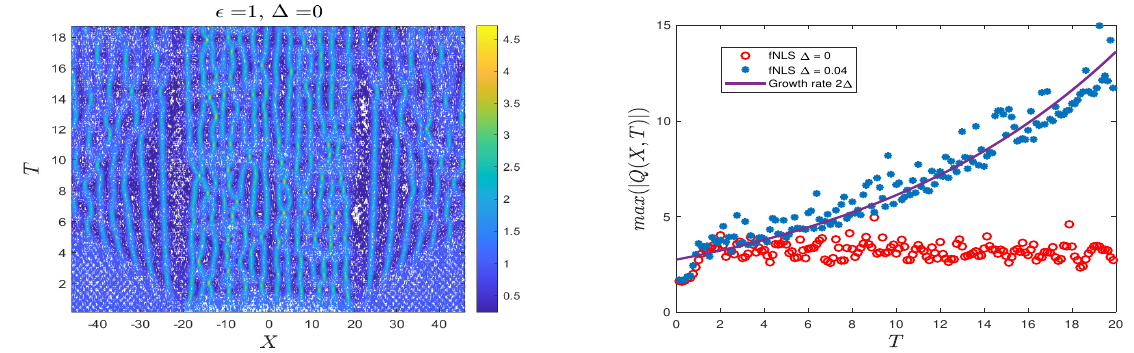
Figure 26. Initial random noise, Case 4: Contour plots of | Q | when ∆ = 0 ( left ) and the maximum of | Q ( X , T ) | with the predicted growth rate 2 ∆ ( right ) when M = 1, (cid:101) = 1.0 and K =